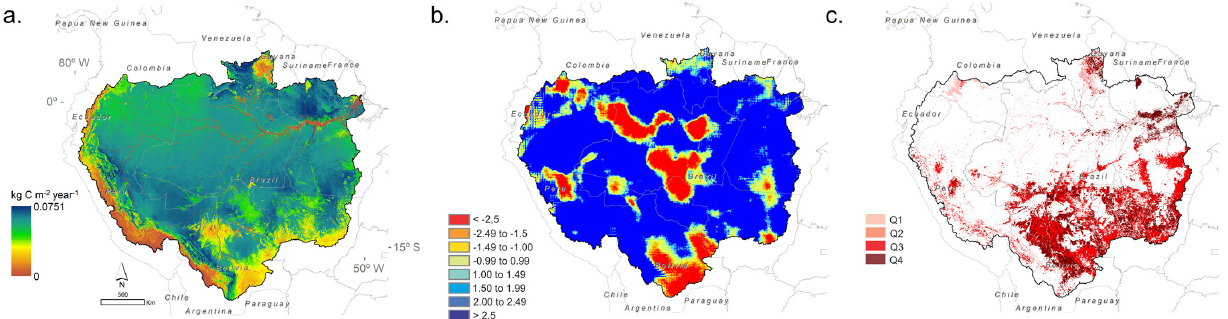
Figure 7. General representation of the Amazon Basin during the period 2001–2019, including ( a ) the study period average gross primary productivity (GPP, kg C m − 2 ); ( b ) the sum of each year’s standardized precipitation index (SPI); and ( c ) the sum of the burned areas (quarters, Q1–Q4). Exact values of the variables mentioned for the Amazon Basin are listed in Table S1. Table 1. Trend analysis ( p -value) applied to annual time series fire foci, rainfall, standardized precipitation index (SPI), emissions, and gross primary production